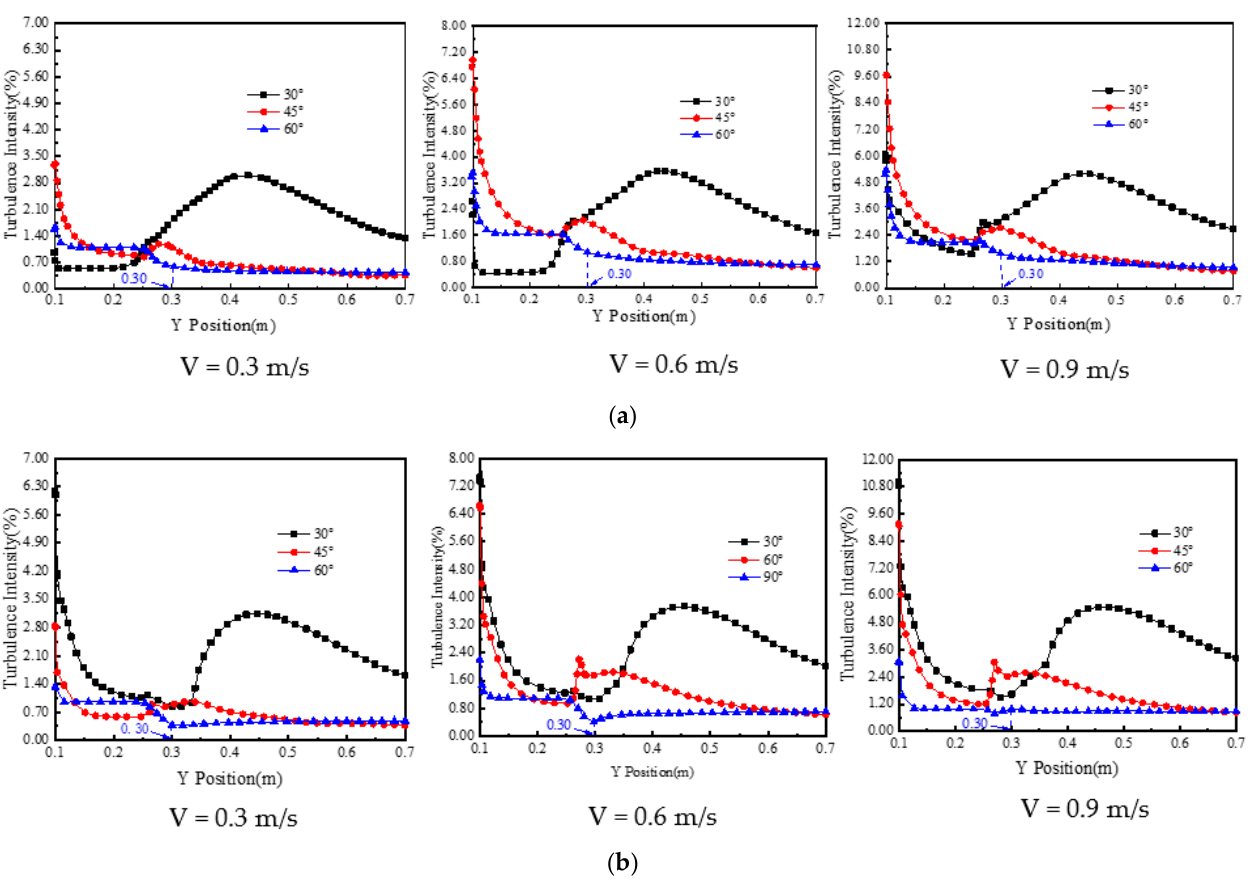
Figure 9. Graph showing the changes in turbulence intensity along the Y-axis with the inlet angle. ( a ) Changes in turbulence intensity along the Y-axis corresponding to L 1 . ( b ) Changes in turbulence intensity along the Y-axis corresponding to L 2 .